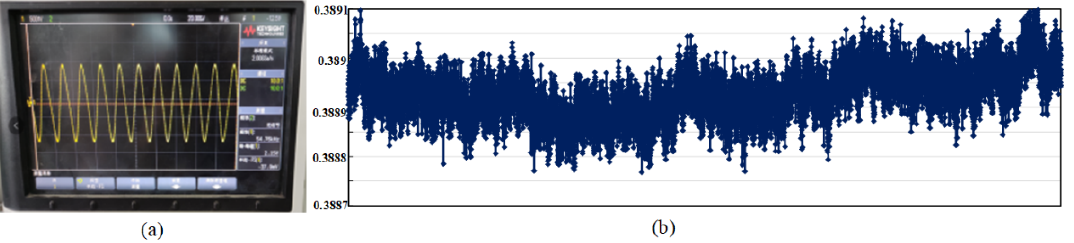
Figure 21. MEMS gyroscope driving stability measurement results: ( a ) Driving detection voltage signal; ( b ) Driving test signal stability measured result.